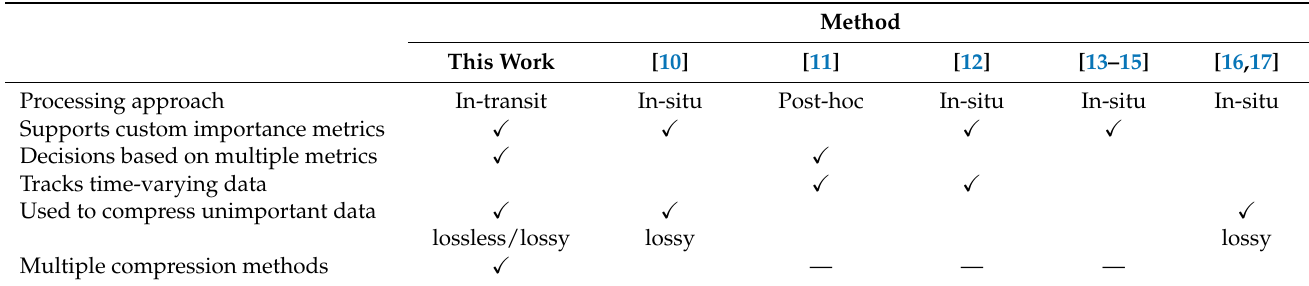
Table 1. Comparing features of related work [10–17] to this